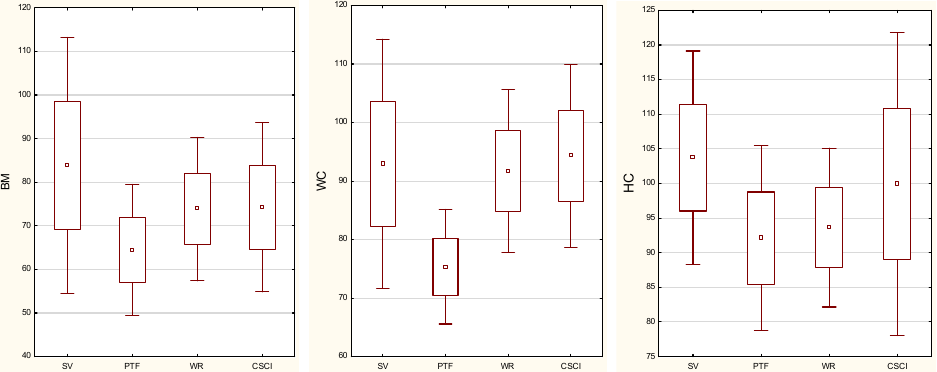
Figure 1. Distribution (mean and SD) of body weight (BM), waist circumference (WC), hip circumference (HC) in the study groups (SV—sitting volleyball players; PTF—Para track and field athletes; WR—wheelchair rugby player; CSCI—cervical spinal cord injury). Table 2. Post hoc test for multiple comparisons of anthropometric characteristics.